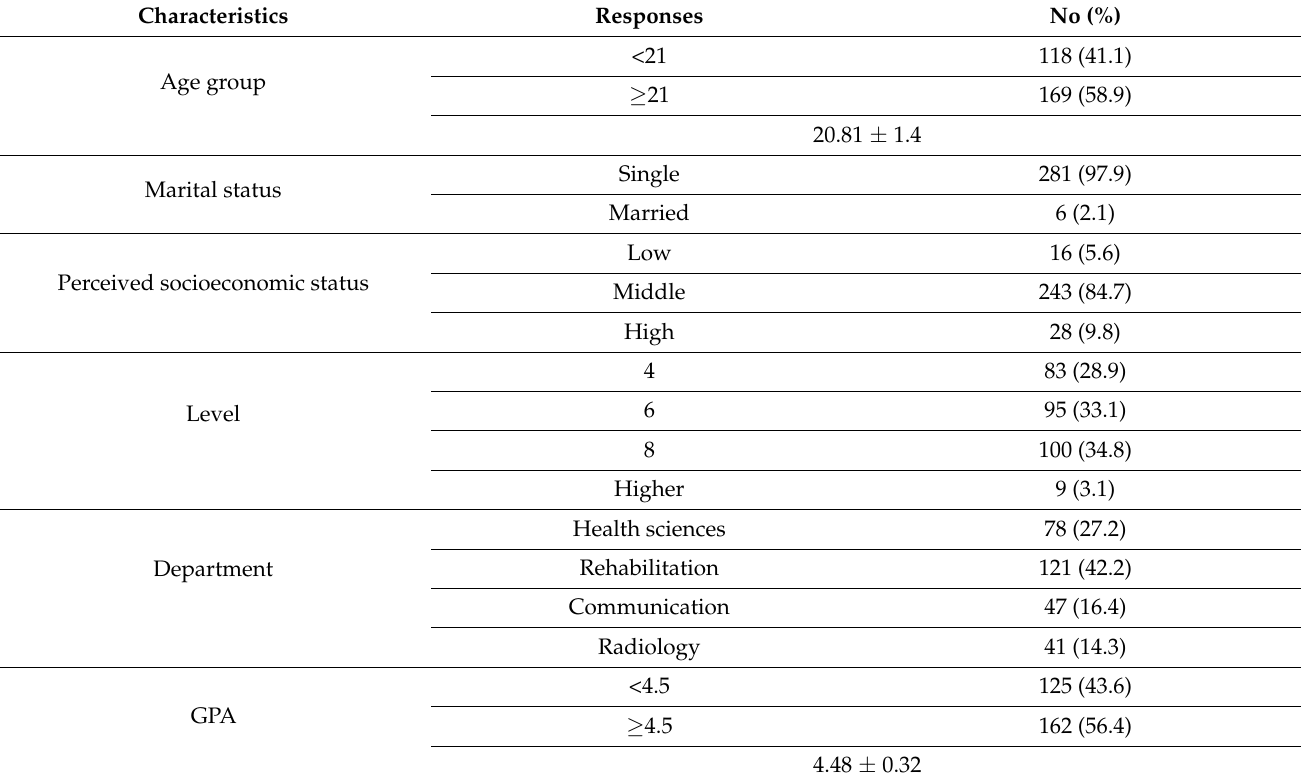
Table 1. Descriptive stats for Personal characteristics of the respondent